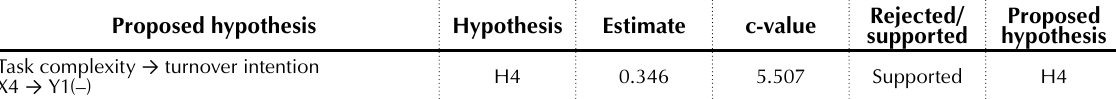
Table 4. Path coefficient of task complexity and turnover intention